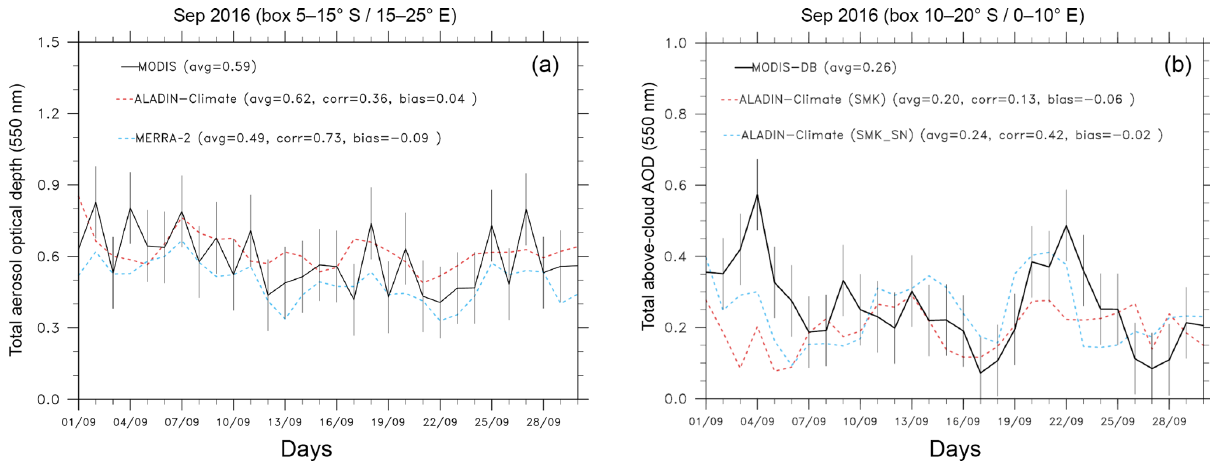
Figure 4. Total daily mean AOD (at 550nm) averaged over box_S (5–15 ◦ S, 15–25 ◦ E) from the ALADIN-Climate model (10:30 and 13:30UTC outputs are used), MERRA-2 and derived from MODIS Aqua DT data (a) . Daily mean ACAOD (at 550nm) estimated from the MODIS-DB satellite and two different configurations of the ALADIN-Climate model (SMK and SMK_SN) averaged over box_O (0–10 ◦ N,